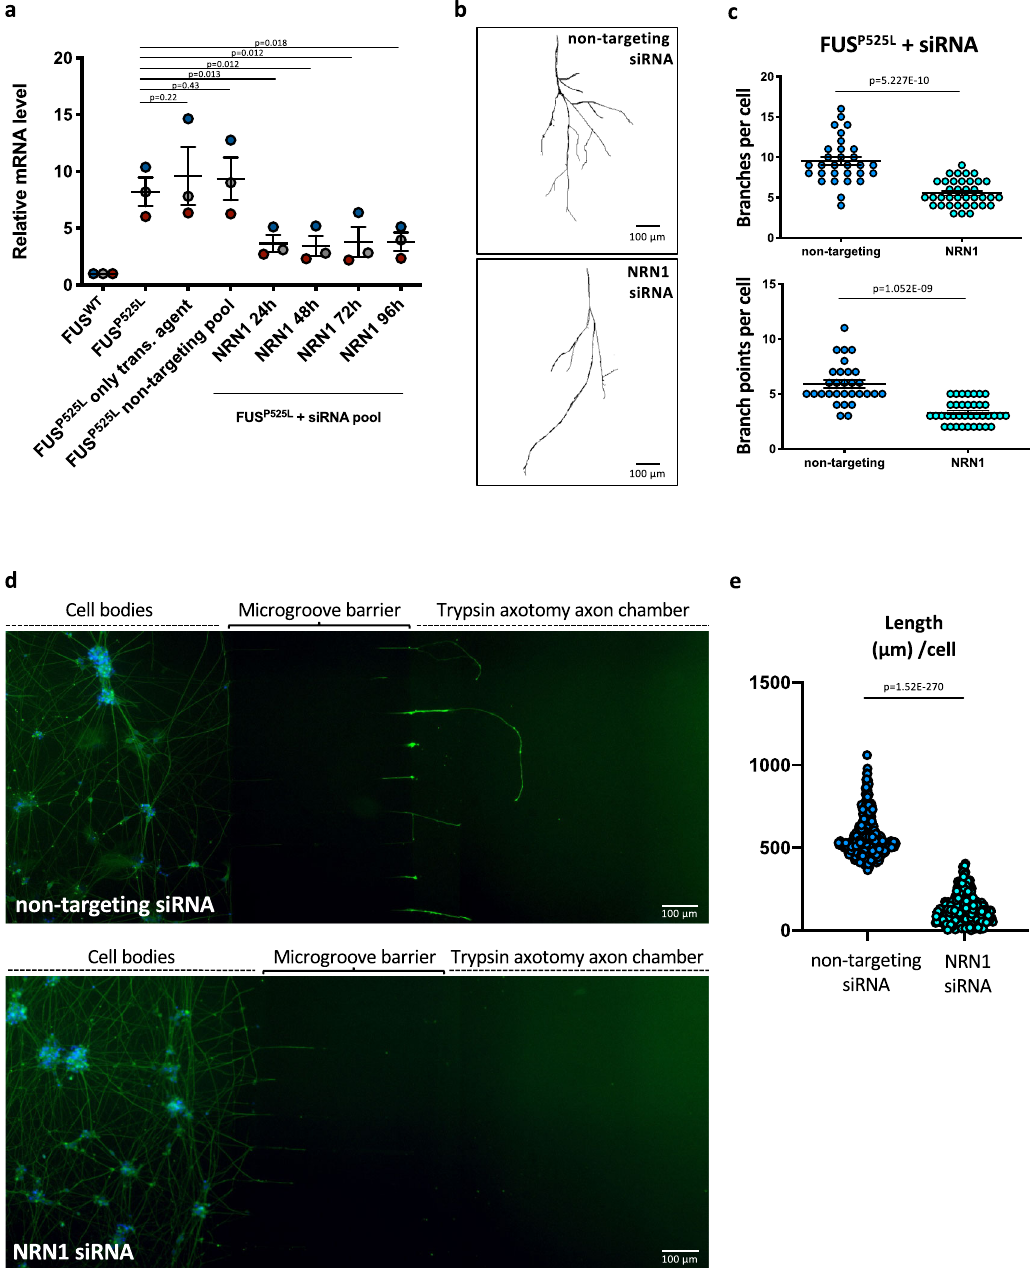
Fig. 8 NRN1 knockdown rescues the aberrant axon growth phenotype in mutant FUS MNs. a Analysis of the mRNA levels of the indicated genes by real time qRT-PCR in untransfected FUS WT and FUS P525L hiPSC-derived spinal MNs and FUS P525L hiPSC-derived spinal MNs transfected with non-targeting control siRNAs or siRNAs targeting NRN1. Values are shown as relative to untransfected FUS WT samples. The graph shows the average from three independent transfection experiments (indicated by different color of the dots), error bars indicate the standard deviation (Student ’ s t -test; paired; two tails). b Representative images, generated with the Skeleton plugin of ImageJ, showing axons of FUS P525L hiPSC-derived MNs, transfected with the indicated siRNA pools, in the axon chamber of compartmentalized chips. Scale bar: 100 μ m. c Quantitative analysis of the number of axon branches and branch points. Immunostaining of TUBB3 was carried out 5 days after transfection of the indicated siRNA pools in FUS P525L hiPSC-derived MNs cultured in compartmentalized chips. The graphs show the average from fi ve independent transfections of non-targeting or NRN1 siRNAs from three differentiation experiments, error bars indicate the standard error of the mean (Student ’ s t -test; unpaired; two tails). d Immunostaining of TUBB3 (green) in FUS P525L hiPSC-derived spinal MNs cultured in compartmentalized chips, transfected with non-targeting control siRNAs or siRNAs targeting NRN1, treated with trypsin in the axon chamber to induce axotomy after 24 h, and allowed to recover for 24 h. DAPI (blue) was used for nuclear staining. Scale bar: 100 μ m. e Graph showing quantitative analysis of axon length in MNs treated as in d from seven independent transfections of non-targeting or NRN1 siRNAs from two differentiation experiments, error bars indicate the standard error of the mean (Student ’ s t -test; unpaired; two tails).